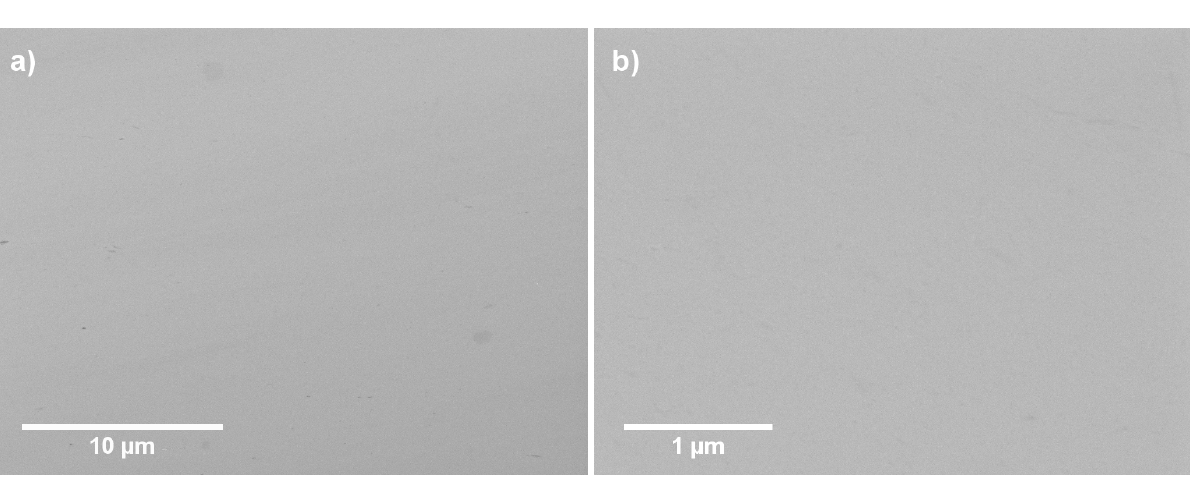
Figure 2. SEM images taken from regions near the center of the High Pressure Torsion (HPT) disk at different magnifications (lower magnification ( a ) and higher magnification ( b )). The crack-like defects are the result of unfinished welding of the metallic glass powder. The distance between the cracks correlates with the particle size of the powder.